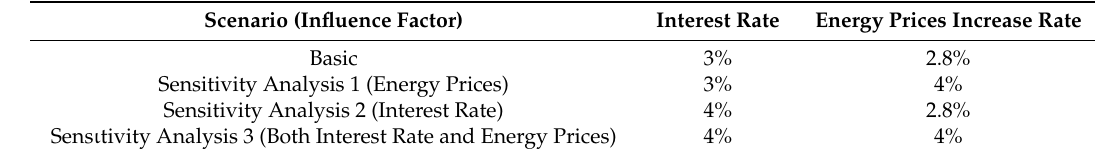
Table 6. Macroeconomic calculation scenarios based on influence factors.